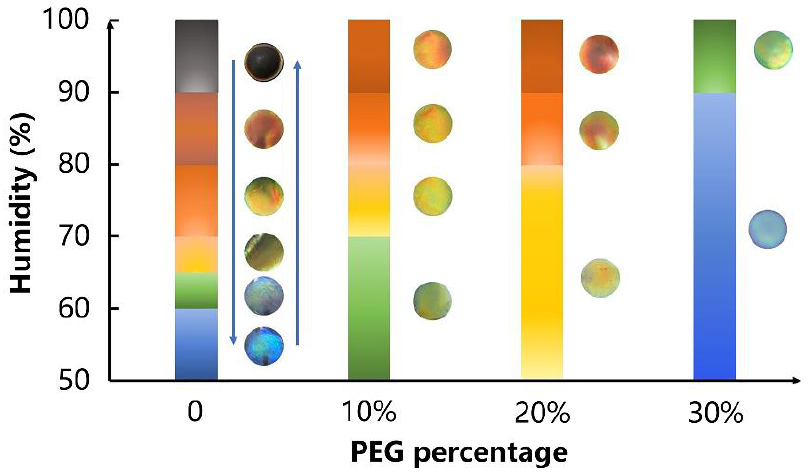
Figure 5. Schematic diagram of the humidity response of CNC-PEG composite films. The left side of each column corresponds to the color of the films.